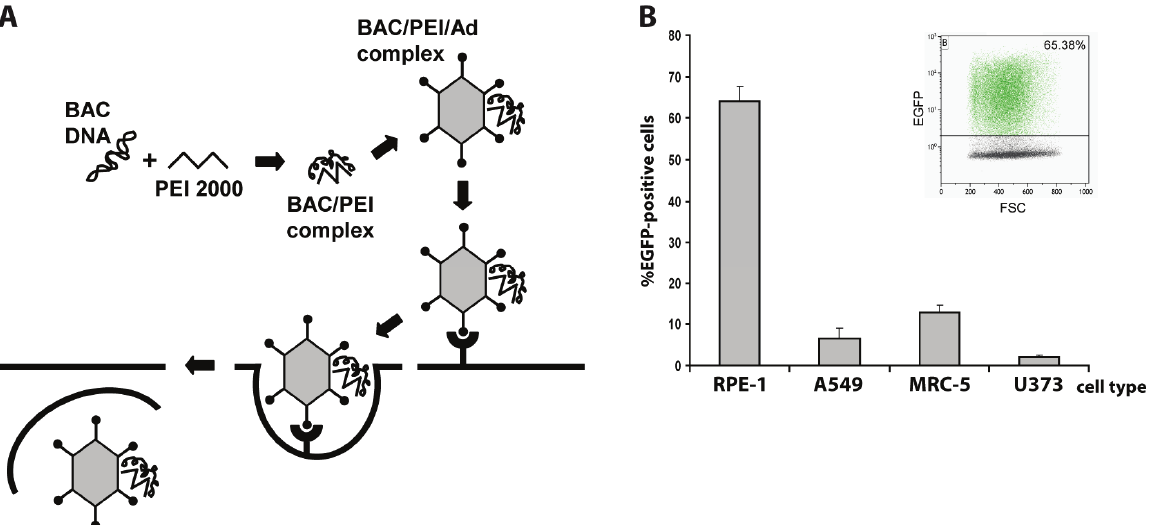
Figure 1. ( A ) Principle of the adenofection method. BAC DNA is condensed with low molecular weight polyethylenimine (PEI 2000). Addition of replication-incompetent, chemically and physically inactivated adenovirus particles leads to binding of the BAC-PEI complexes to the virions. The DNA-loaded adenovirus particles are taken up by the cells, and the endosomolytic activity of virion protein helps to release the DNA into the cytosol; ( B ) Adenofection of different human cell types with the EGFP-expressing HCMV BAC pHG-13. RPE-1: retinal pigmented epithelial cell line, A549: lung adenocarcinoma epithelial cell line, MRC-5: primary embryonic lung fibroblasts, U373: human astrocytoma cell line. Transfection efficiency is given as percentage of EGFP-positive cells on day 1 post transfection. Transfections were done in quadruplicates, and standard deviations are indicated. Inlay: example of FACS analysis of adenofected RPE-1 cells.